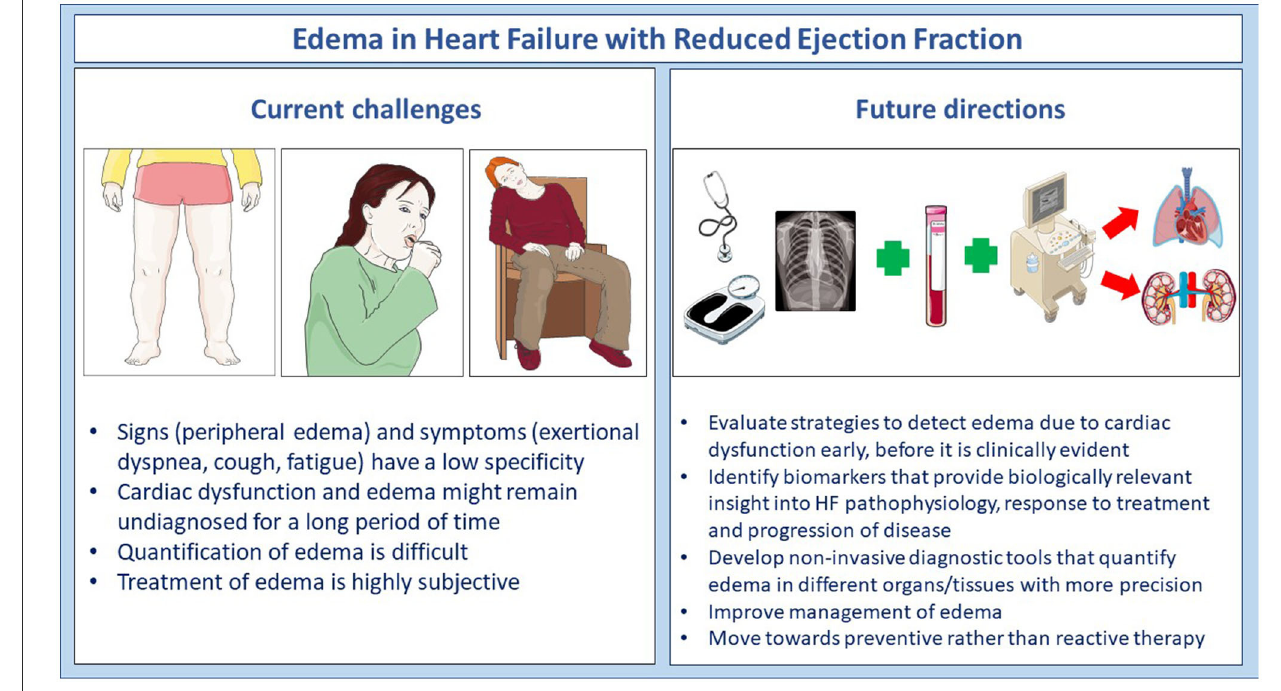
FIGURE1 Current challenges and future directions in the identification and management of edema in patients with heart